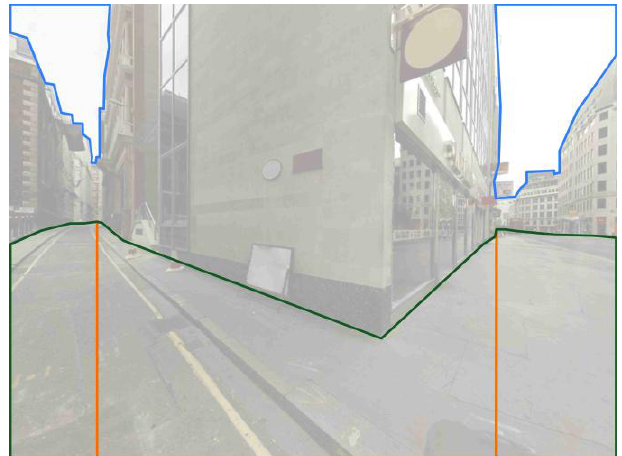
Figure 7. Three space-geometric measures: floor area (outlined in green), longest line of sight (orange) and sky area